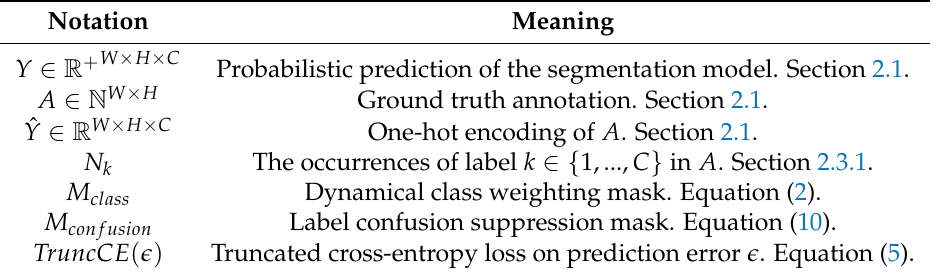
Table 1. Mathematical notations used in this paper. Notation Meaning Probabilistic prediction of the segmentation model. Section